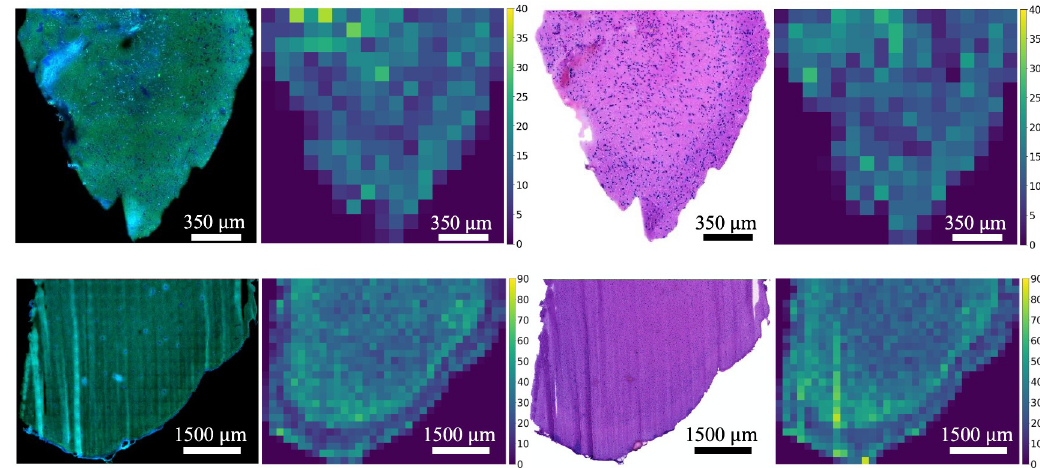
Fig 8. Cell density heatmaps of the second testing region for the two specimens. The first and third columns are SRS and H&E images; The second and fourth columns are the corresponding cell density heatmaps for SRS and H&E images.